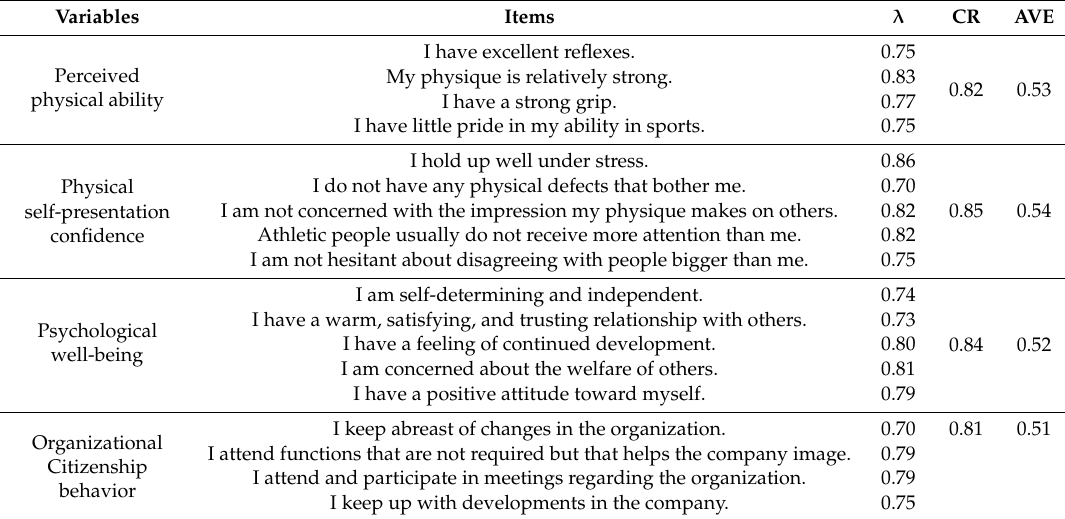
Table 2. Factor loadings ( λ ), composite reliability (CR), and average variance extracted